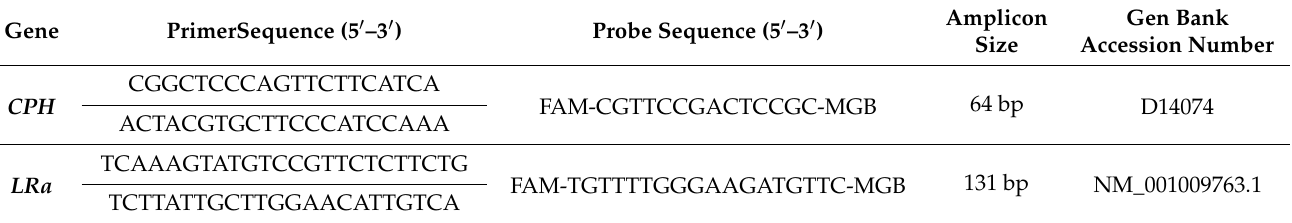
Table 1. Sequences of oligonucleotides used as primers and probes to analyze the mRNA expression of cyclophilin ( CPH ; reference gene), the short form of the leptin receptor ( LRa ; target gene) in sheep. Gene PrimerSequence (5 (cid:48) –3 (cid:48) ) Probe Sequence (5 (cid:48) –3 (cid:48)